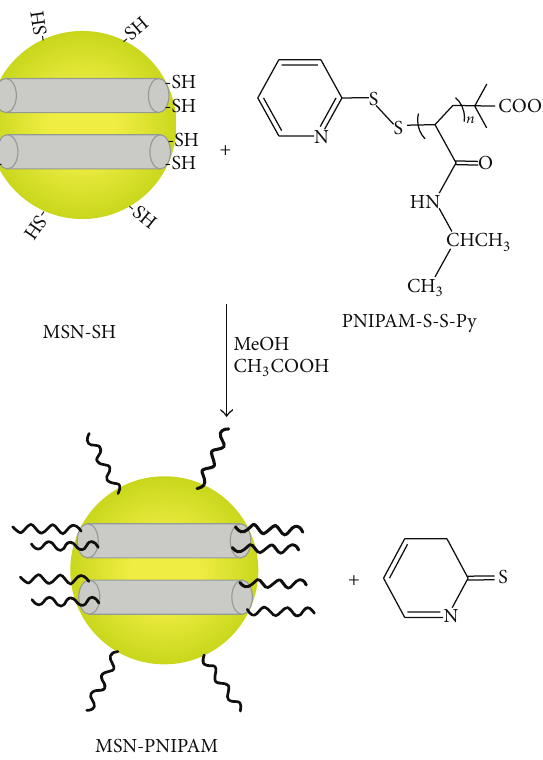
Figure 3: Reaction of MSN particles- (MSN-) SH with PNIPAM-S- S-Py to form MSN-PNIPAM (reproduced from [54], with permis- sion from American Chemical